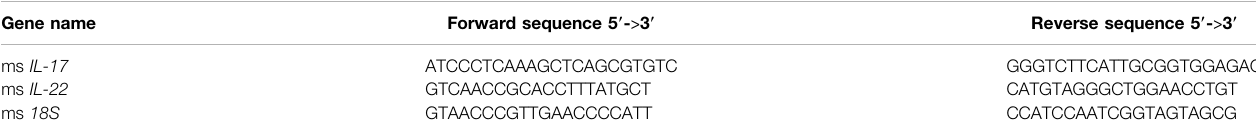
Supplementary Figure S1 . Two-sided Student ’ s t-test was used to examine the difference between disease controls and healthy volunteers at baseline (see Figure 1 ), and two-sided paired t -test was used to examine the changes at baseline vs.